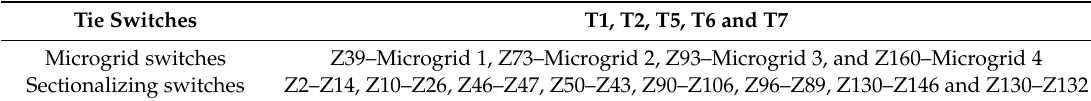
Table 2. Switches selected for upgrade.